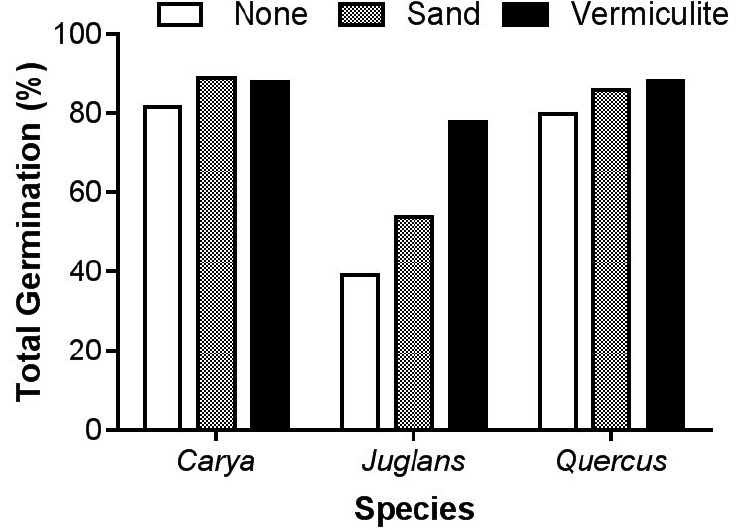
Figure 2. Germination success of Carya laciniosa, Juglans cinerea, and Quercus rubra seeds when stratified in either sand, vermiculite or without media over winter.